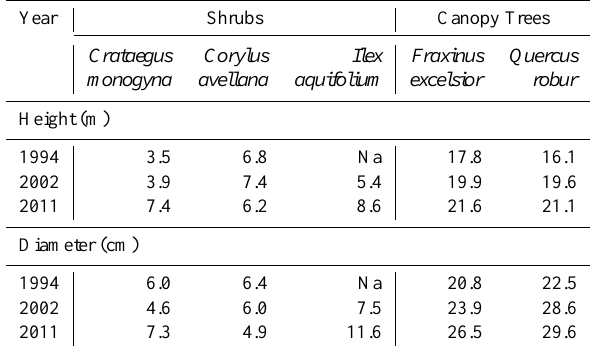
Table 1. Mean annual biometric mensuration data for understorey and canopy tree species at the Straits Inclosure, Alice Holt Forest, for the period